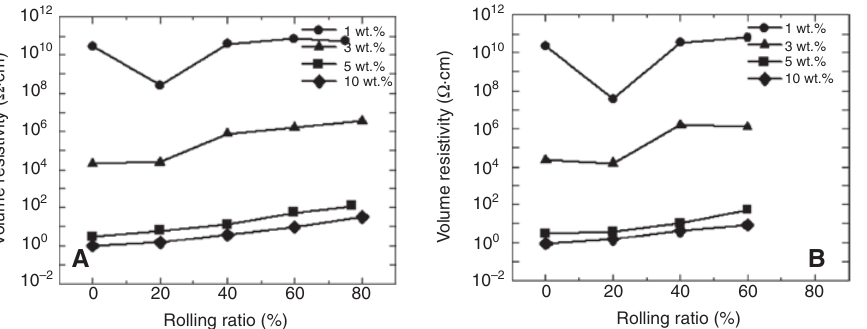
Figure 7: Volume resistivities of prepared composites at various rolling ratios: (A) parallel to rolling direction; (B) perpendicular to rolling